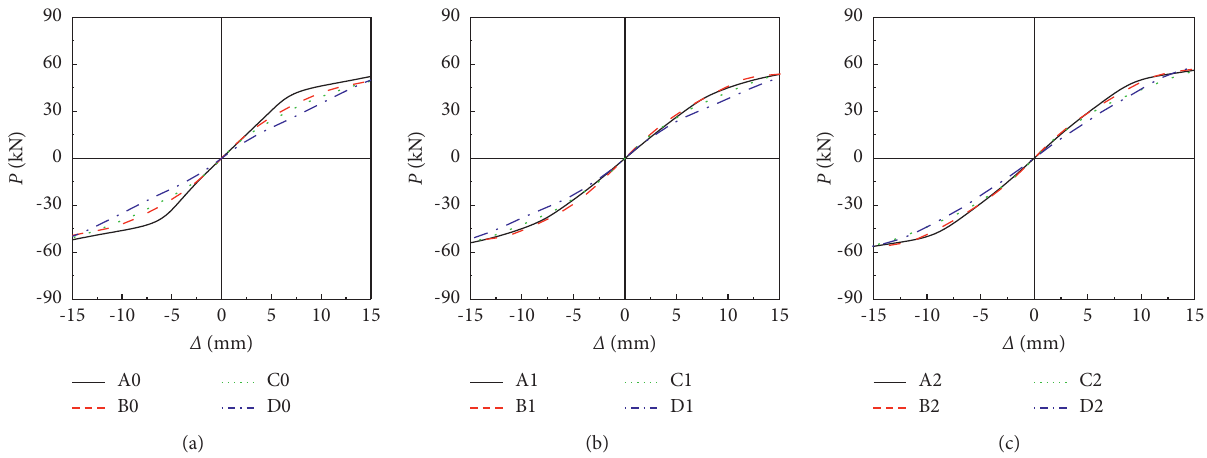
Figure 11: The local section on P - Δ skeleton curve of specimens. (a) η � 0 specimens. (b) η � 0.157 specimens. (c) η � 0.314